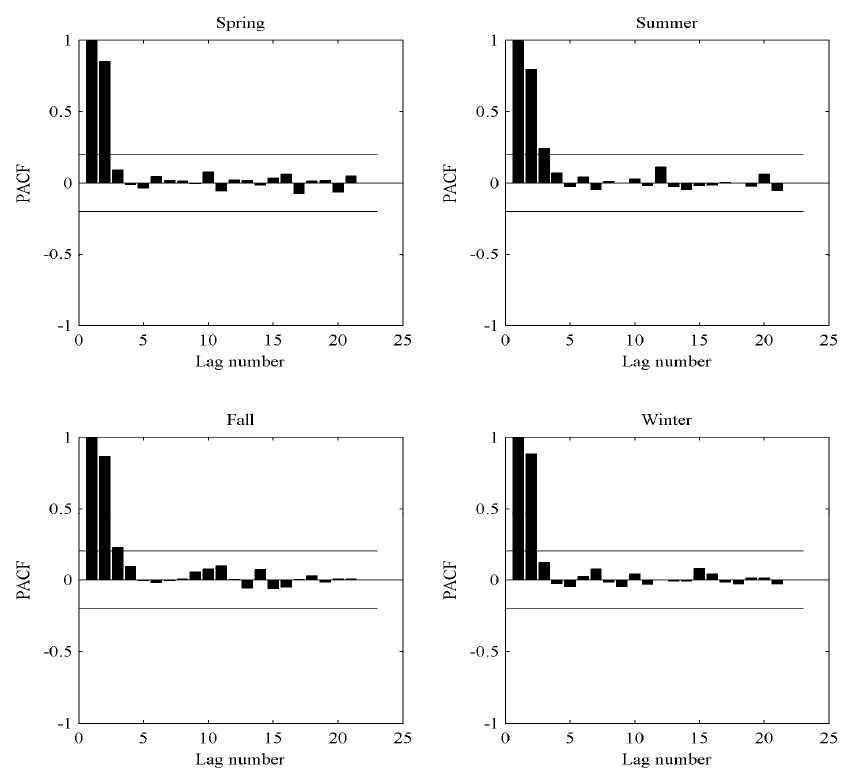
Figure 7. Plots of PACF against the lag length in four trend components. Table 3. The input nodes number of the trend component for the prediction models in four cases.